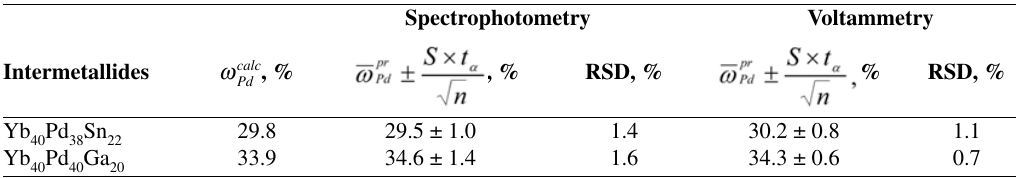
Table 4. Results of the determination of palladium(II) in the alloy, n = 3, P =